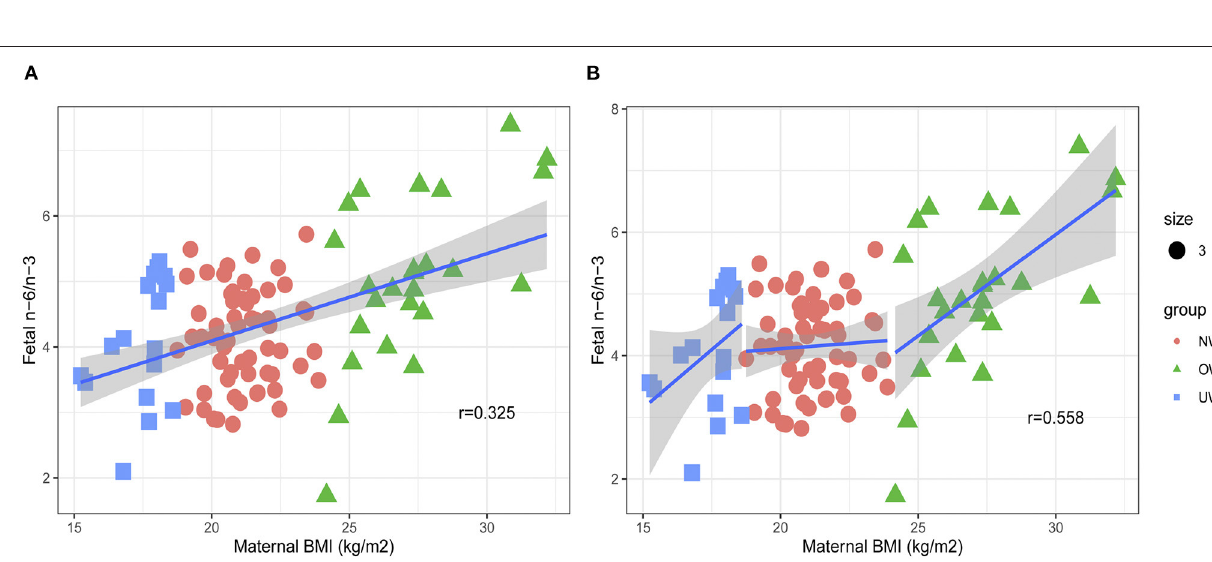
In the subgroup analysis, the correlation between maternal pre- BMI and DHA with cord plasma DHA can be observed only in OW mothers ( p < 0.05), but not in NW subjects.